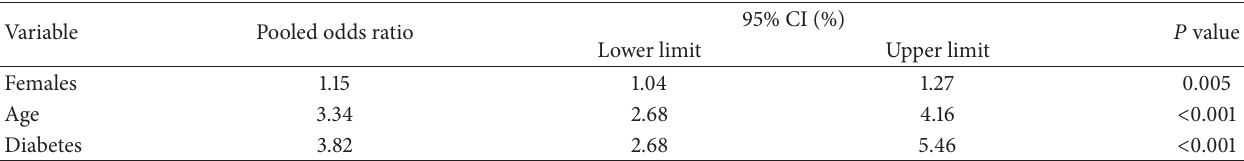
Table 3: The pooled odds ratio for risk factors of